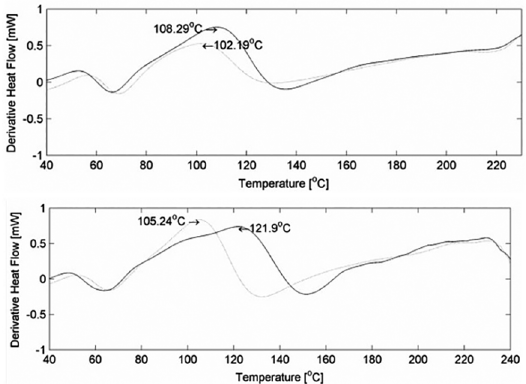
Figure 7. Derivative of heat flow versus temperature curves of: top) co-bonded; bottom) secondary bonding